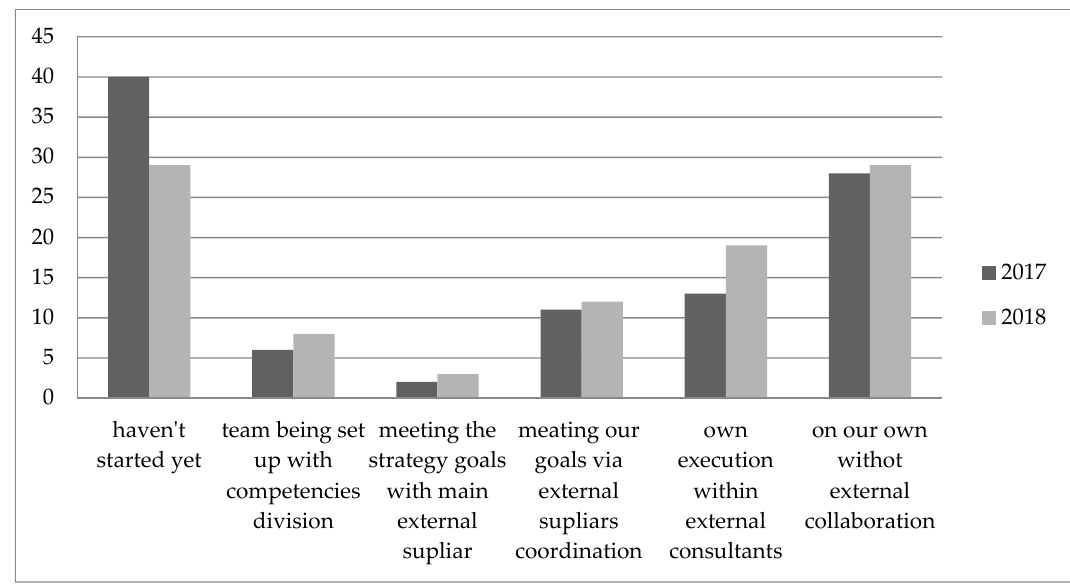
Figure 3. The way how to put Industry 4.0 into action in %. Source: own processing based on survey results.